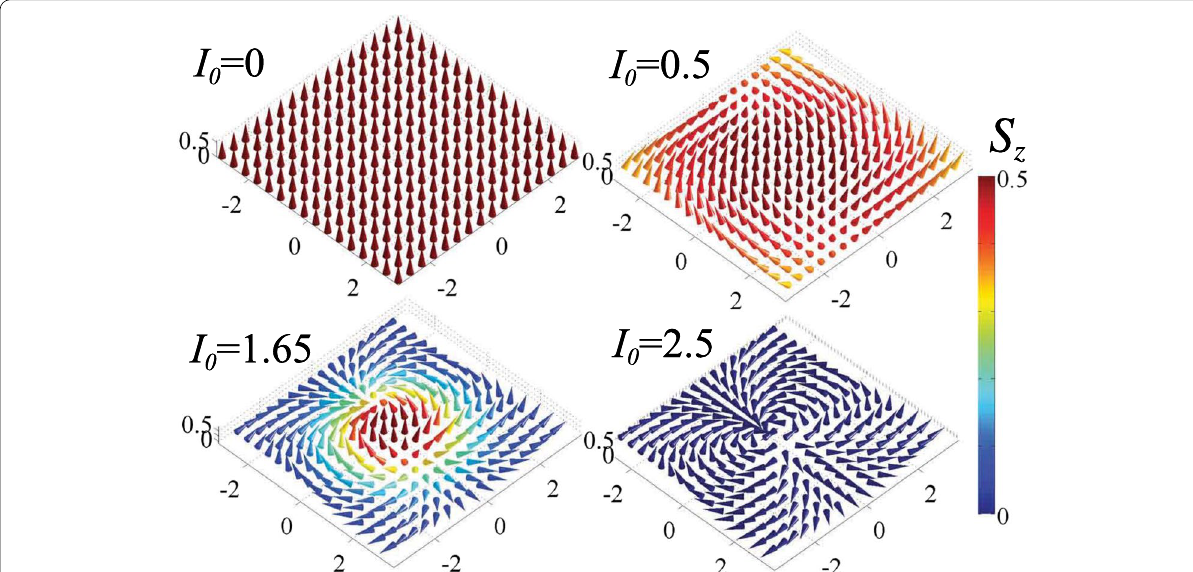
Fig. 4 Spin texture of the ground state of a SOAM‑coupled system at different coupling strengths. The arrows point in the direction of the local spin S , and the color represents the projection of the spin onto the z axis. The figure is adapted from Ref. [46], as well as corresponding parameters